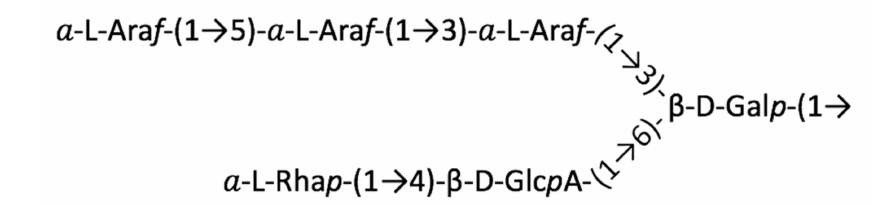
Figure 1. Scheme of the AGP side chain originated from the work of Defaye and Wong (1986)